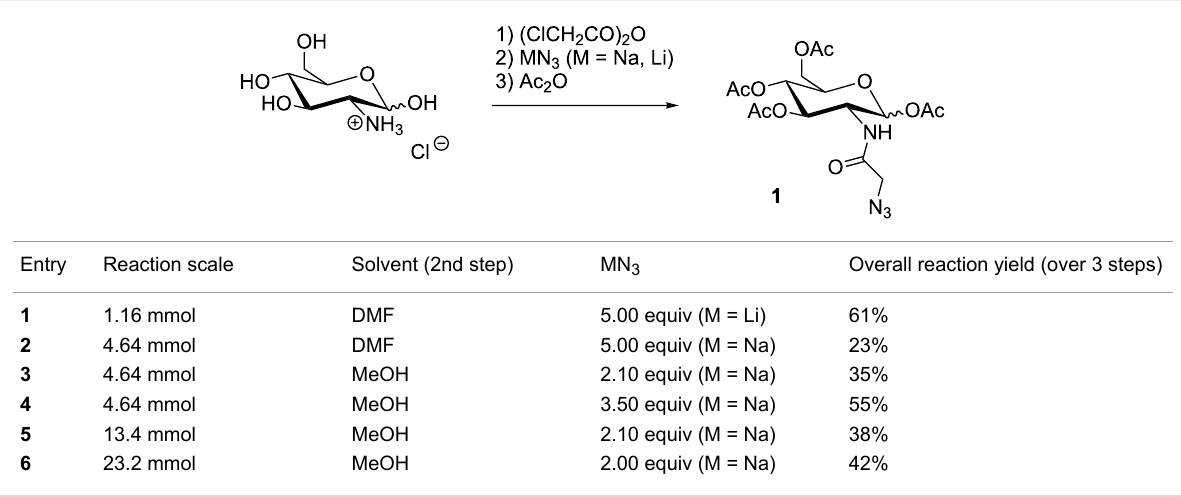
Table 1: Optimization of the synthesis of azide 1 .